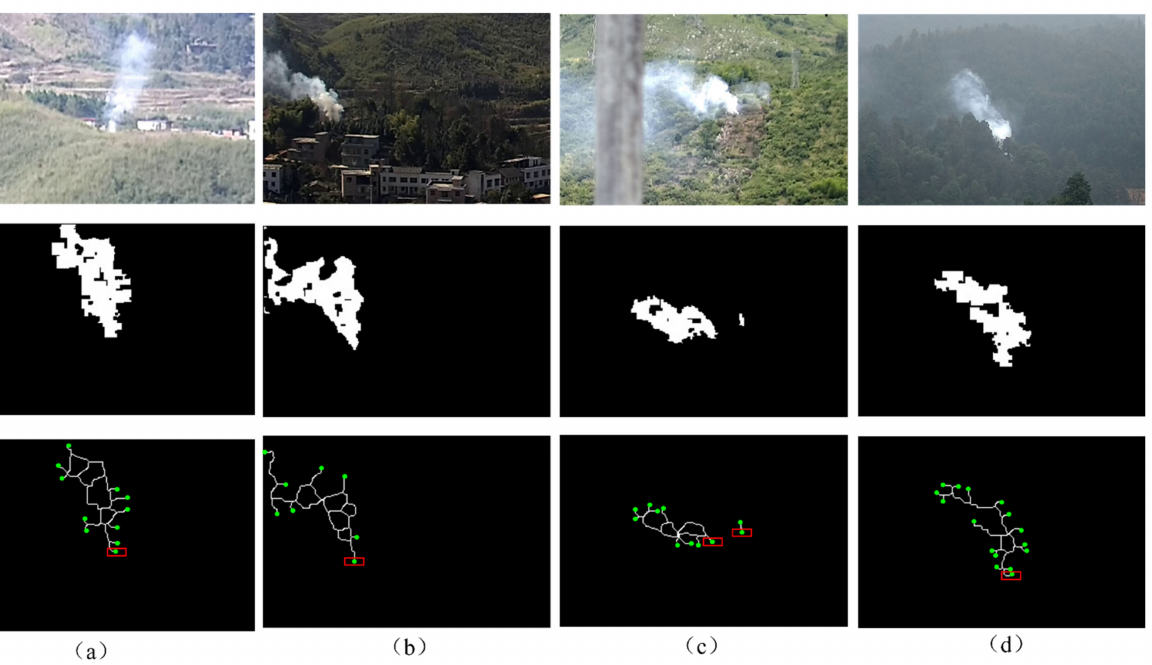
Figure 4. Original images (the first row), fusion images (the second row) and the smoke skeleton images (the third